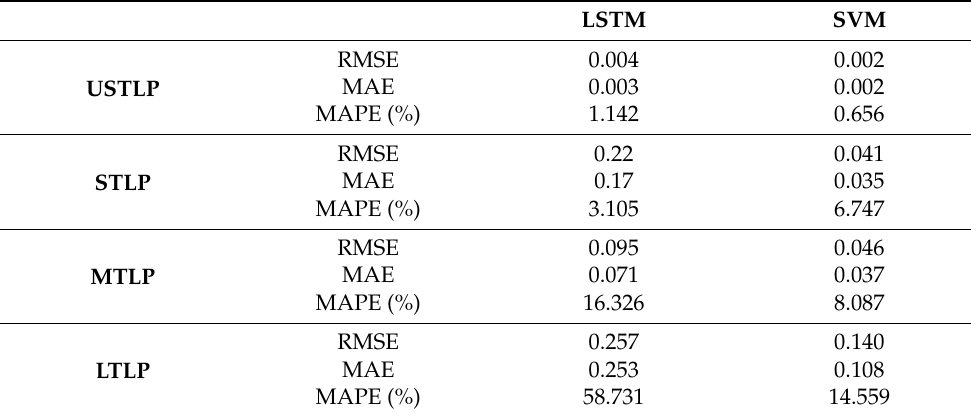
Figure 15. SVM blind test. Table 6. Model metric for two algorisms in a blind